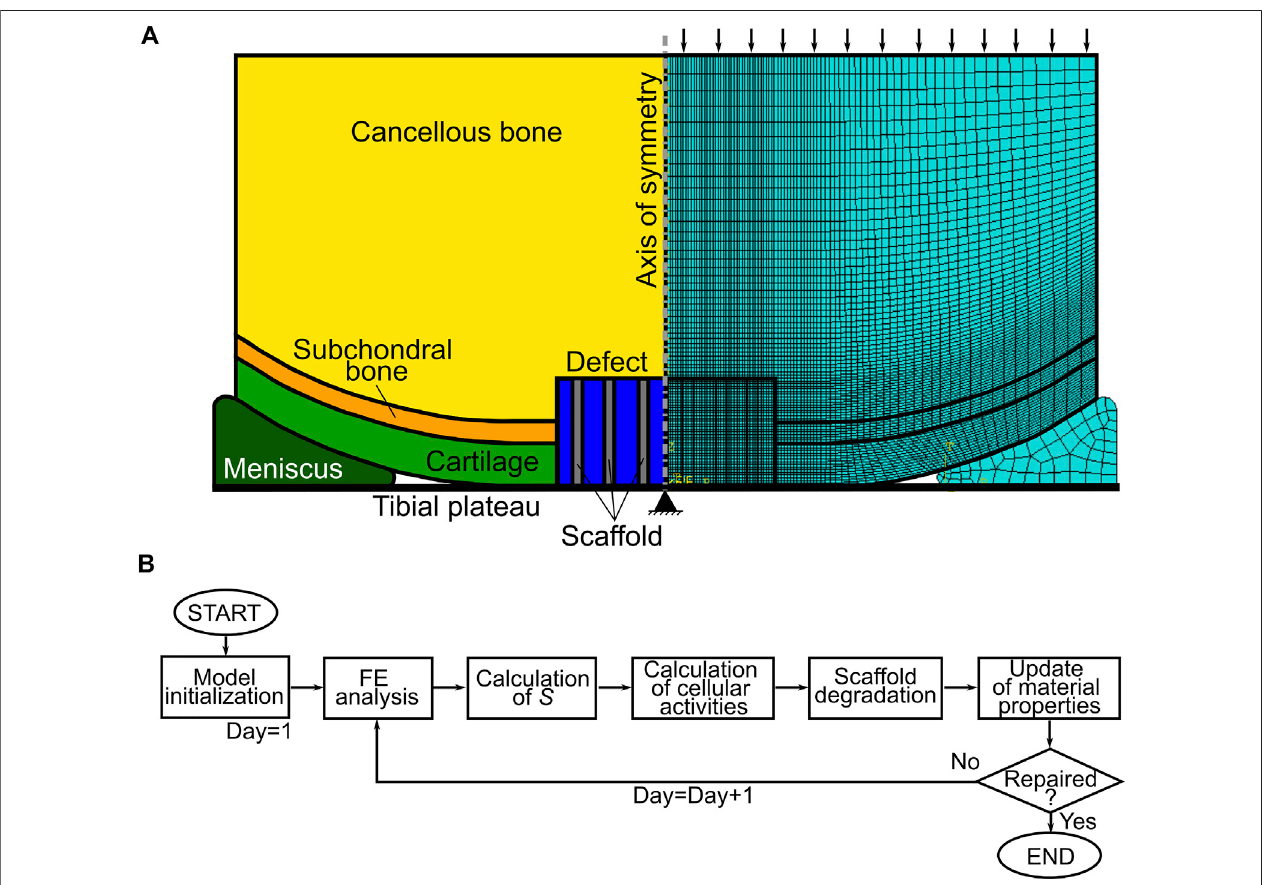
FIGURE 1 | Model of osteochondral defect repair. (A) Geometry (left) and mesh (right) of the axisymmetric model of knee femoral condyle. Black arrows and the blacktriangleshow theapplied pressureand theencastreboundary conditionin the fi niteelement (FE)analysis,respectively; (B) work fl ow ofthe model. S =mechanics- dependent stimulus of tissue